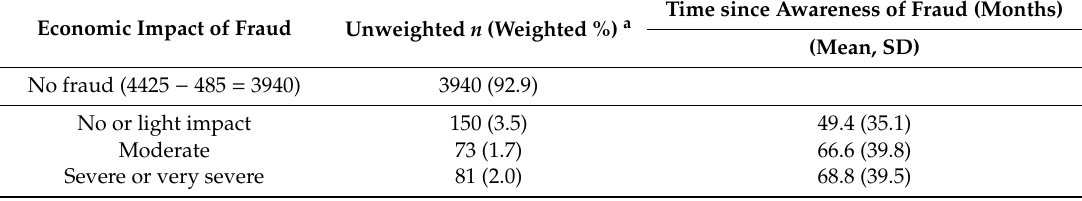
Table 2. Economic impact of fraud on family finances.